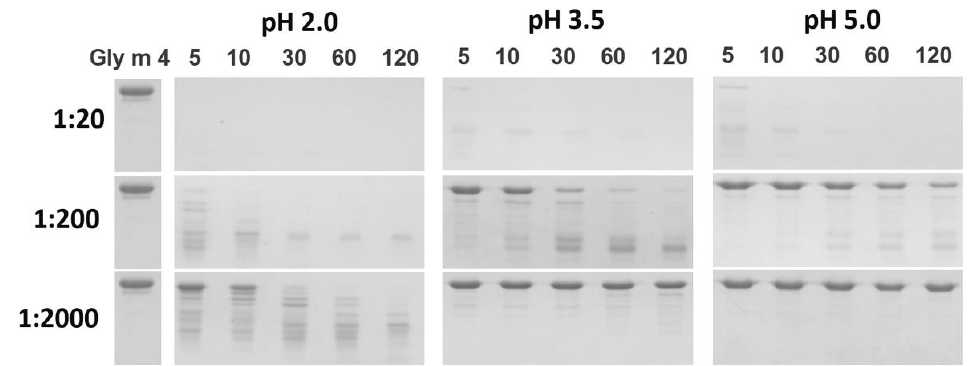
Figure 3. The effects of different pH values and enzyme loading on pepsin digestion of Gly m 4, as determined by SDS-PAGE (Gly m 4 — the allergen without pepsin; 5, 10, 30, 60, and 120 — digestion time, min; 1:20, 1:200, and 1:2000 — pepsin-to-allergen mass ratio).